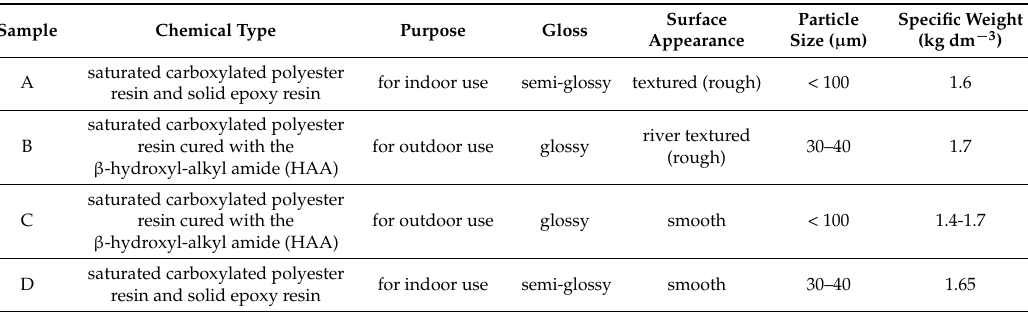
Table 1. Technical data for tested powder